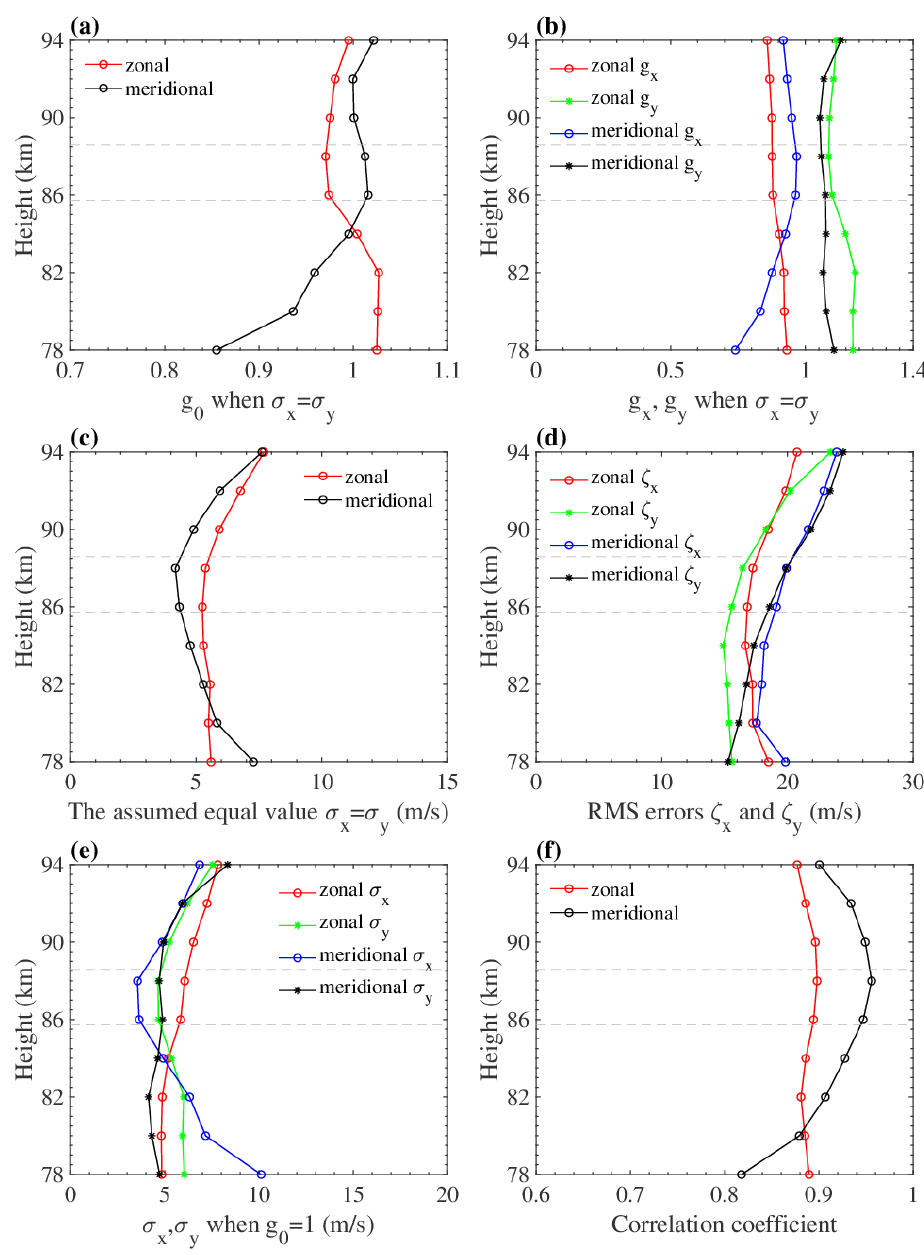
lines are also labeled. ( b ) The mathematical relationship between 𝑔 (cid:2868) , 𝜎 (cid:3051) , and 𝜎 (cid:3052) . The black curve represents the numerical relationship; the green dashed lines represent the values of 𝑔 (cid:2868) , 𝜎 (cid:3051) , and 𝜎 (cid:3052) under the assumption that 𝜎 (cid:3051) and σ (cid:2935) are equal; and the black dashed lines represent the values of random noise when 𝑔 (cid:2868) = 1 .